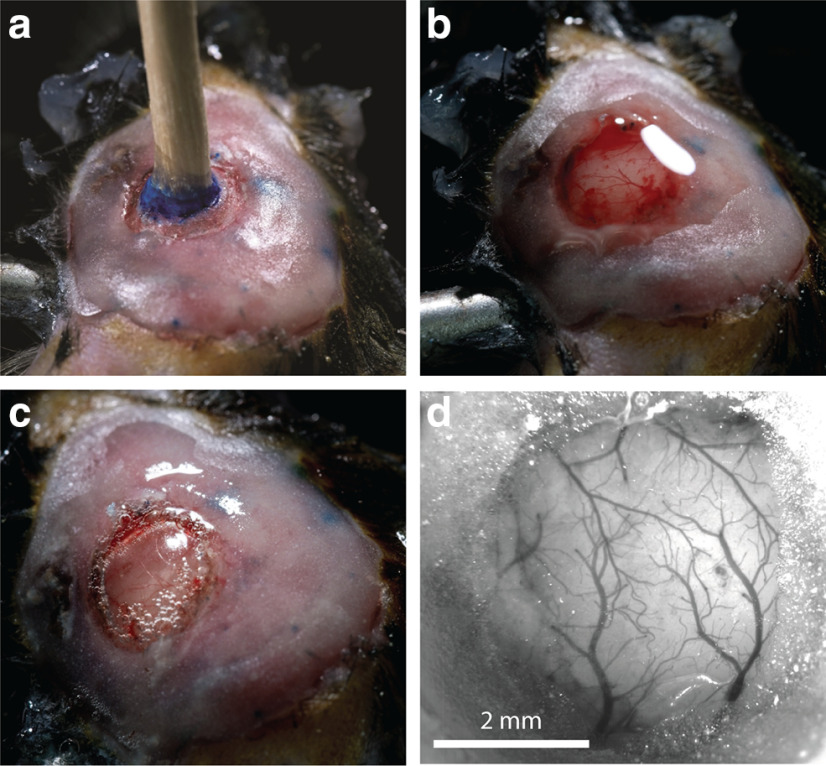
Cranial window surgery. a, After drilling the channel through most of the bone around the circular bone patch, a wooden toothpick was glued to the circular bone patch. Dental cement (pink) covers the bone beyond the window area. The blue ink marked the position of the craniotomy. b, Using the toothpick as a handle, the bone patch was gently removed, and saline was added to wash away any blood. c, Hydrogen peroxide was added to the dura so that a bubble forms. Gel foam, forming a well on the craniotomy, was removed for clarity. d, After dye injection, the bubble below the dura was deflated during the mounting of the window glass. The cranial window was clear and ready for imaging.